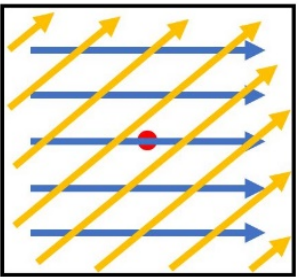
Figure 10. Illustration of how rotational angle changes the laser track on one layer. A blue line represents laser path with 0 degree rotation and a yellow line represents laser path with a rotation angle. The red dot represents the point of interest.